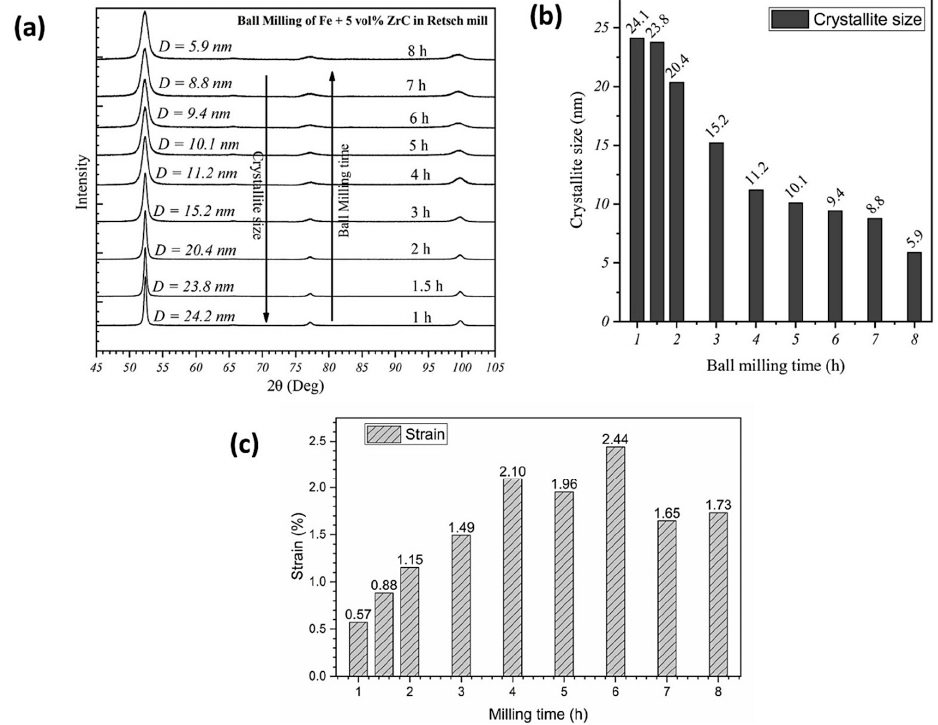
Figure 6. Effect of ball-milling time on crystallite sizes—( a ) XRD patterns showing peak widths, ( b ) crystallite size (by Scherrer analysis) as a function of ball-milling time, and ( c ) lattice strain of the Fe crystallite as a function of milling time.